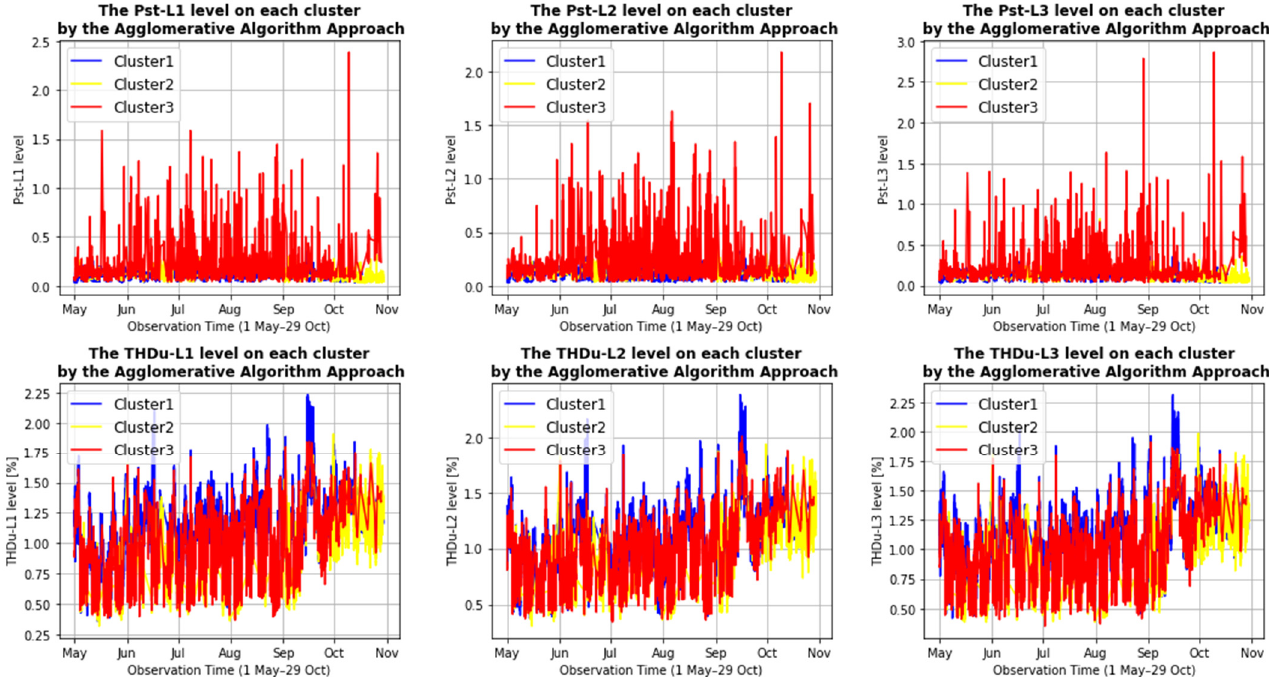
Figure 7. Visualization of PQ parameters’ level of the first investigation object at measurement points 2HPP-MV and 2ESS-MV by the agglomerative algorithm approach.